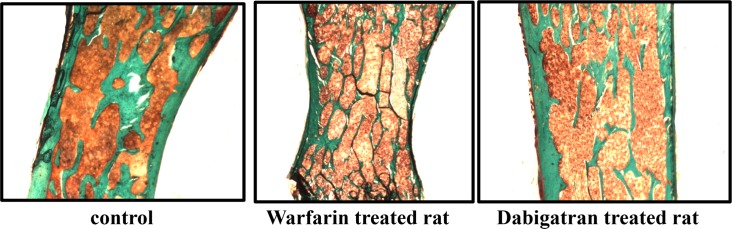
Dabigatran preserves vertebral volume and structure.According to what observed in the femur, analysis of vertebrae showed increased bone volume, trabecular thickness and number, with lesser trabecular separation in rats treated with dabigatran with respect to warfarin treated study animals. Bone of a representative normal control rat is also shown. No significant differences in microarchitecture were observed between study groups. Warfarin treated rats showed thinner trabeculae with increased separation in the marrow space, highlighting a potentially increased fragility, despite similar microarchitecture. (Magnification 100X).